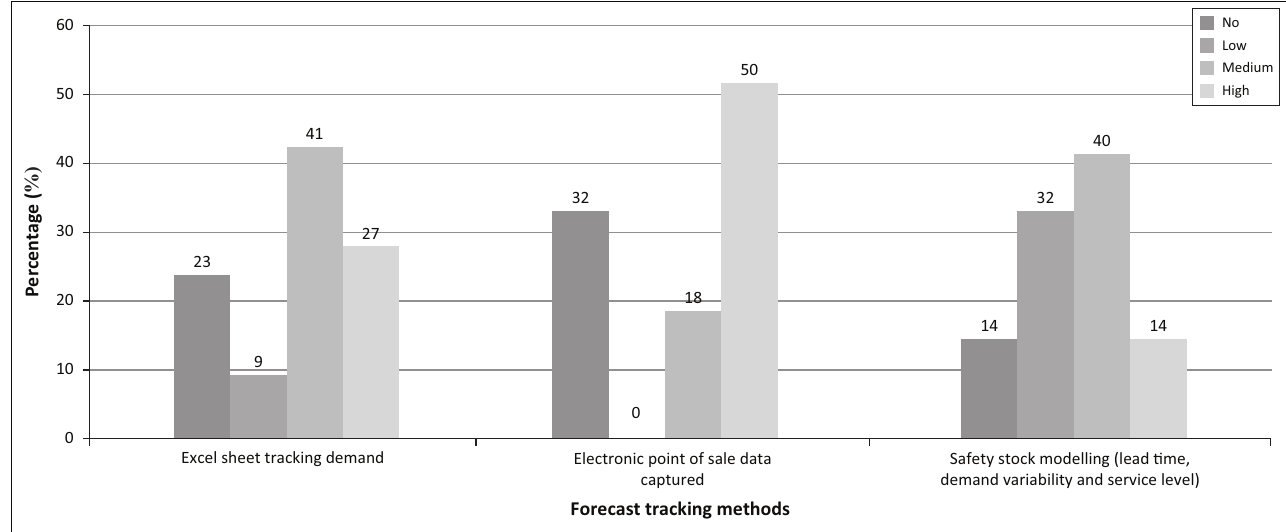
FIGURE 2: Forecast tracking methods (respondents’ rating in %